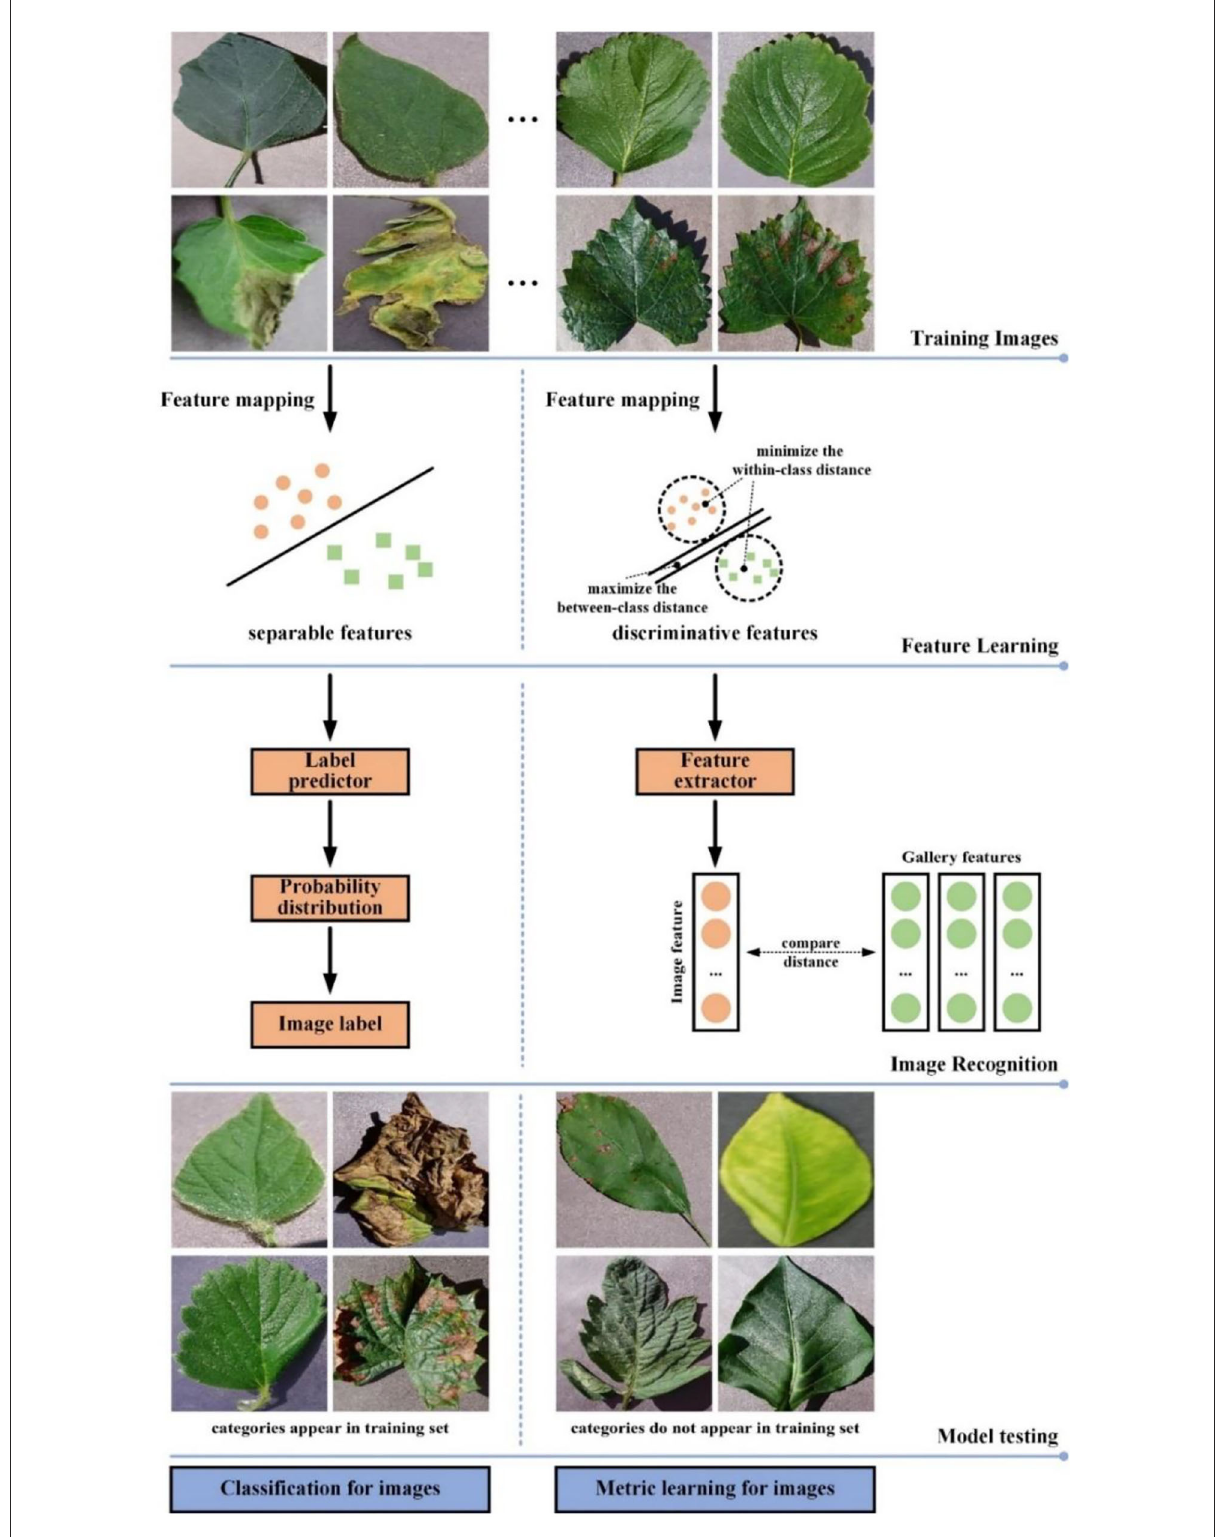
FIGURE1 Comparison of image classification and image retrieval in leaf disease